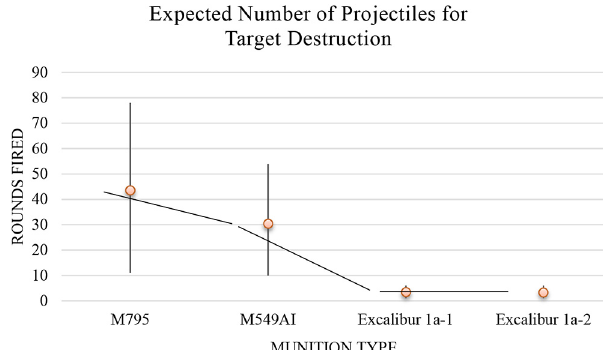
Table IV. Expected value and variance of the number of projectiles fi red per system, with an associated probability of kill